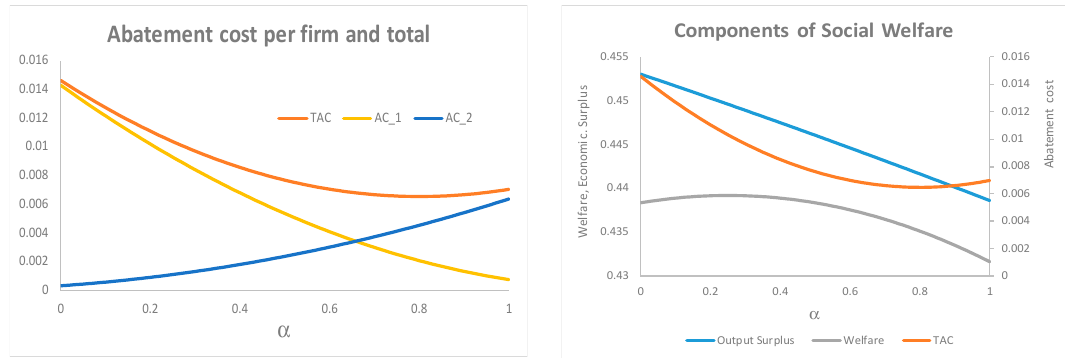
= . Legend: TAC: Total